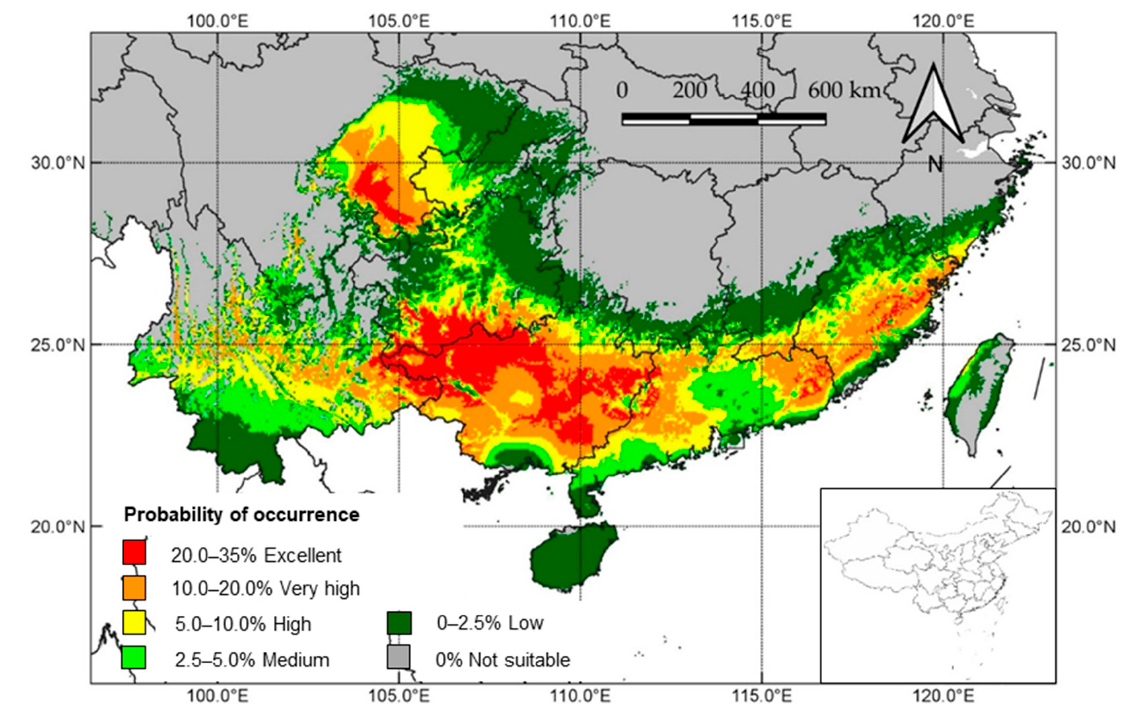
Figure 4. Distribution pattern of habitat suitability of J. mimosifolia in China based on the current climate. The results were obtained from the predictions of BIOCLIM using DIVA-GIS. Different colors from grey to red denote the gradation from low to high habitat suitability, and hence the probability of occurrence.